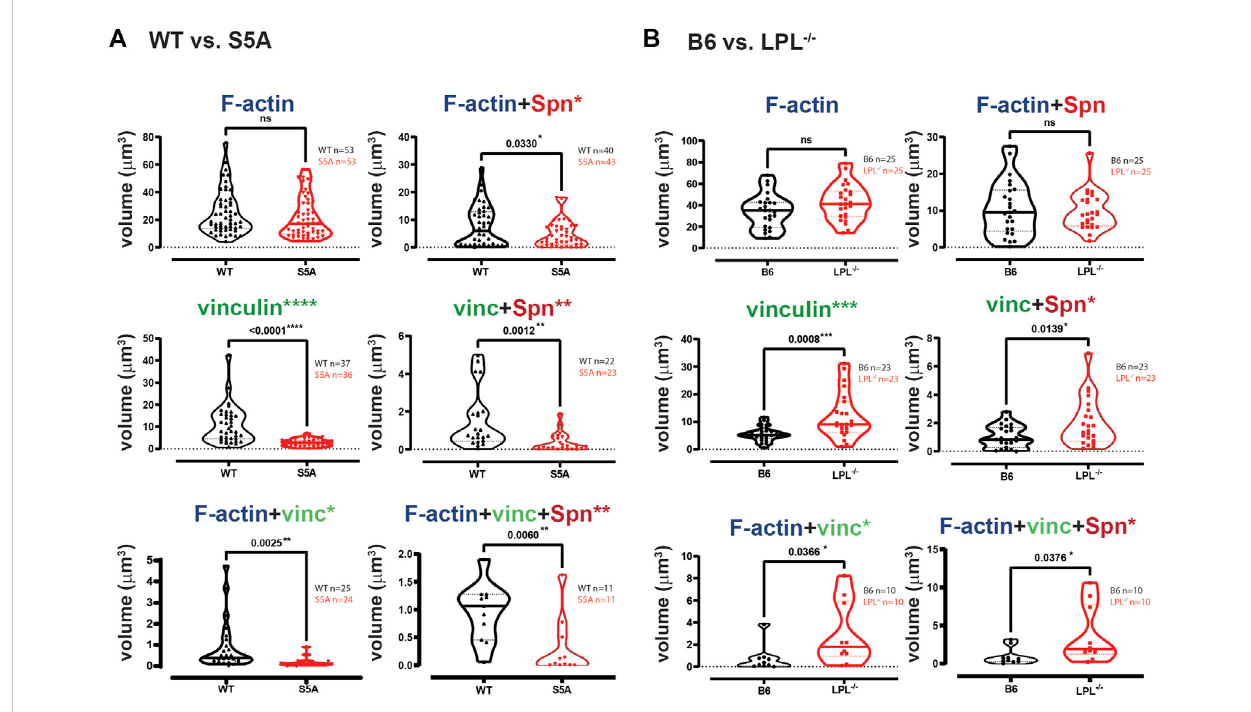
FIGURE 10 Quanti fi cation of volumes of protein aggregates reveals loss of vinculin from phagosomes in AMs expressing S5A-LPL. Imaris software was used to calculate the total volume ( μ m 3 ) of the indicated protein 3D aggregates (images in Figure 9) contributing to pneumococcal phagocytosis by AMs derived from (A) matchedWTandS5Amiceor (B) matchedB6andLPL − / − mice.Eachsymbolrepresentsthevolumecalculatedfromone fi xedcell;n=numberof cells analyzed. Images acquired from two independent experiments. p -values determined by Mann-Whitney; ns = non-signi fi cant, * = p < 0.05, ** p < 0.01, *** p <